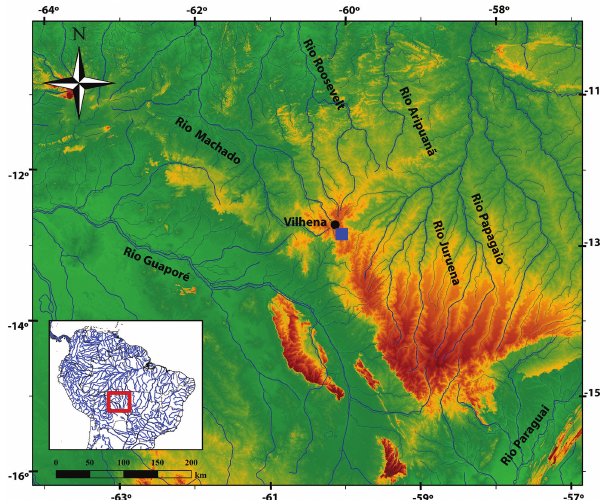
Fig. 3. Type locality (blue square) of Moenkhausia parecis , a tributary of the igarapé Piracolina, upper rio Machado drainage, rio Madeira basin, Brazil.